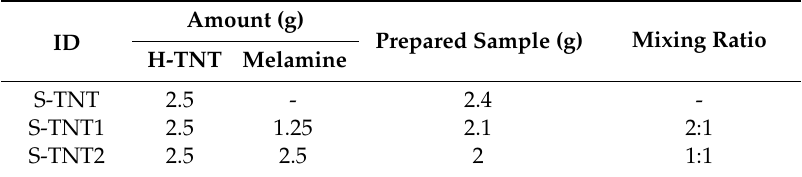
Table 1. Nomenclatures and salient features of the preparation method for prepared composites. S-TNT, sludge generated titanium dioxide nanotube; H-TNT, H-titania